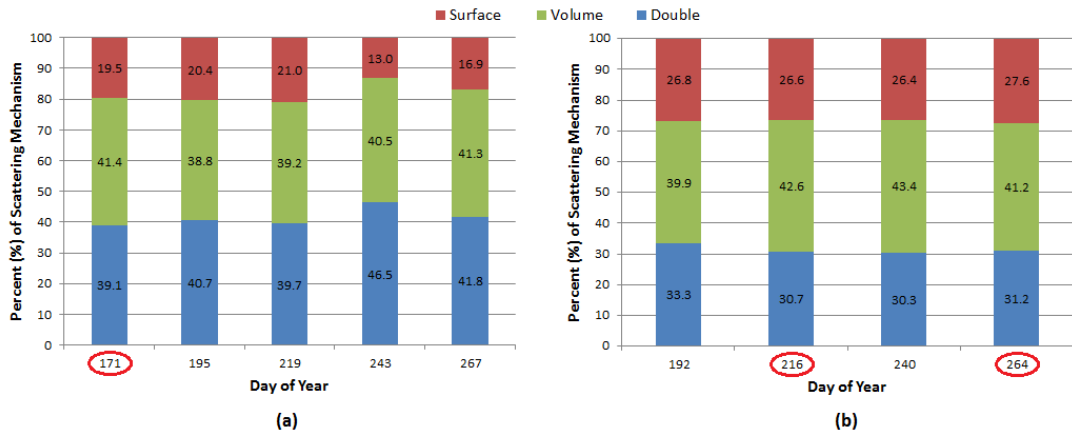
Figure 11 . Urban Freeman-Durden decomposition for ( a ) 41° and ( b ) 26° incidence angles based on RADARSAT-2 fine-quad beam modes. Note that circled days coincide with polarization response plot and Cloude-Pottier decomposition